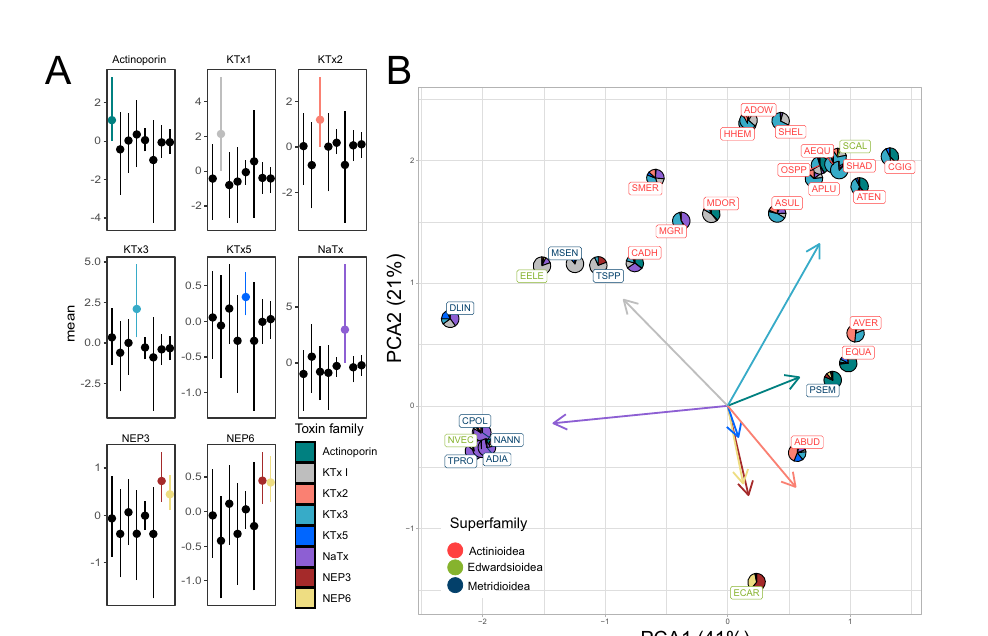
Fig. 2 | Sea anemone venom expression phenotype characterized by a single dominant toxin that evolves through major pulses. A Toxin combinations with signi fi cantphylogeneticcovariancerepresentedincolor,withthosenotsigni fi cant in black and lower and upper 95% con fi dence intervals represented as whiskers.